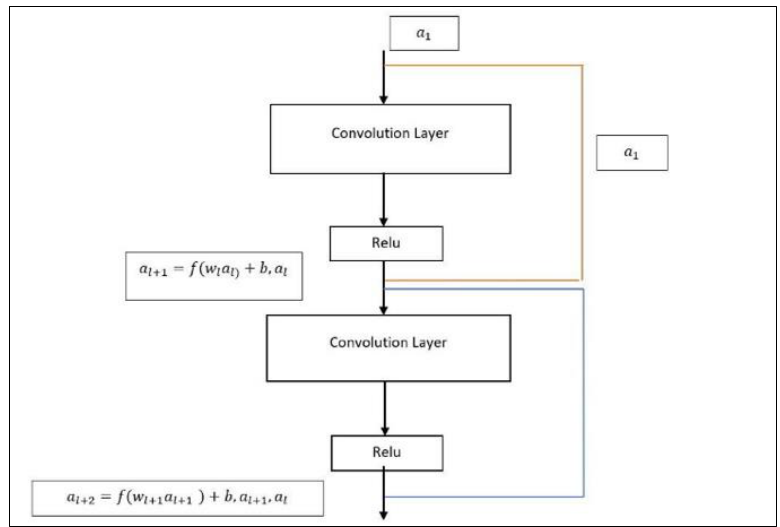
Figure 4. ReLU Algorithm.